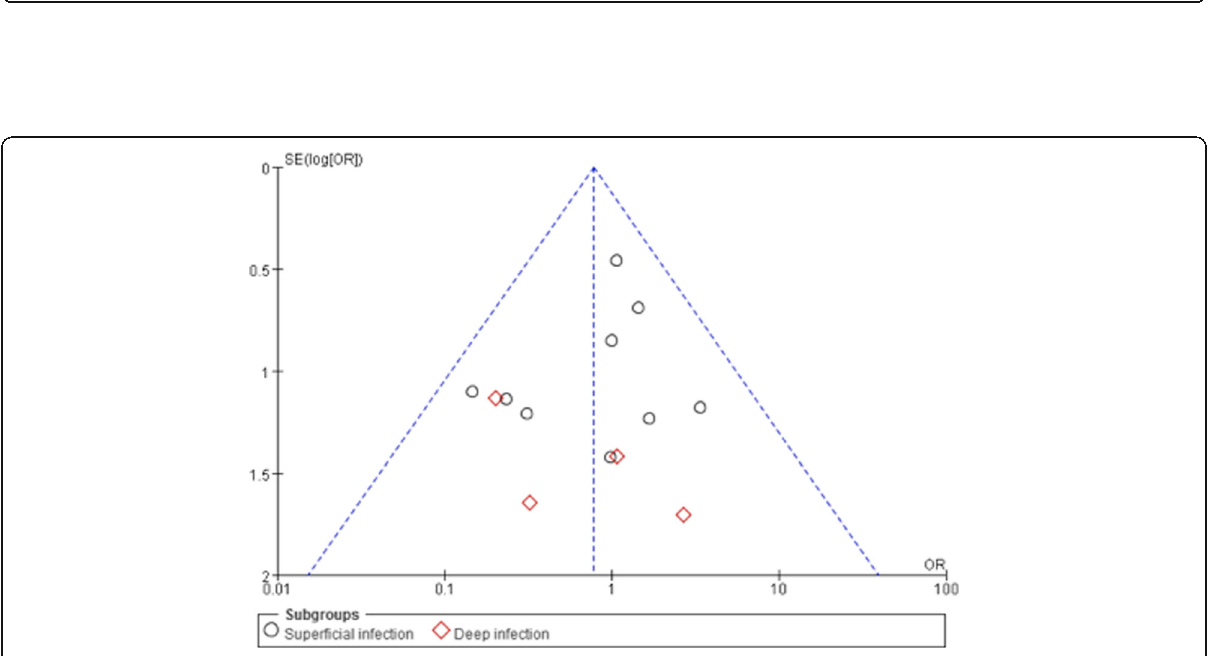
Fig. 5 The results of funnel plot are based on the incidence of infection, which shows distribution of each study in the funnel. Symmetrical distribution suggests no publication